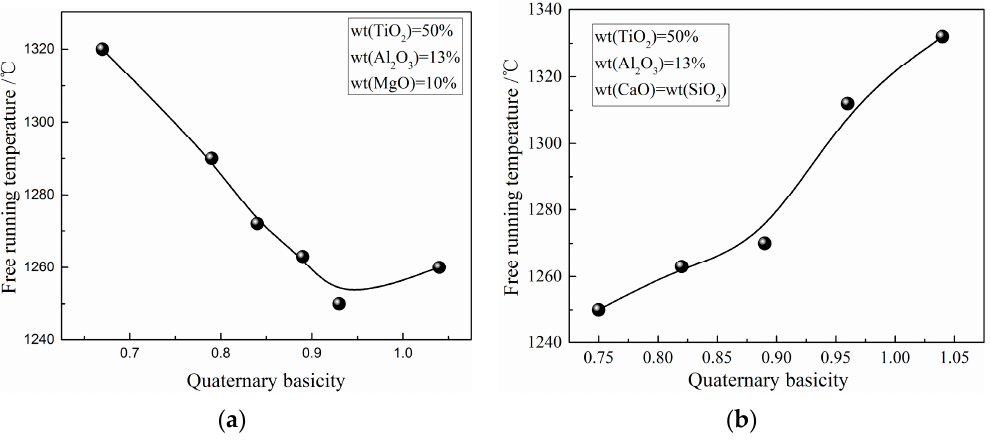
Figure 7. ( a ) Effects of quaternary basicity by addition of CaO content on free-running slag temperature; and ( b ) effects of quaternary basicity by addition of MgO content on free-running slag temperature.